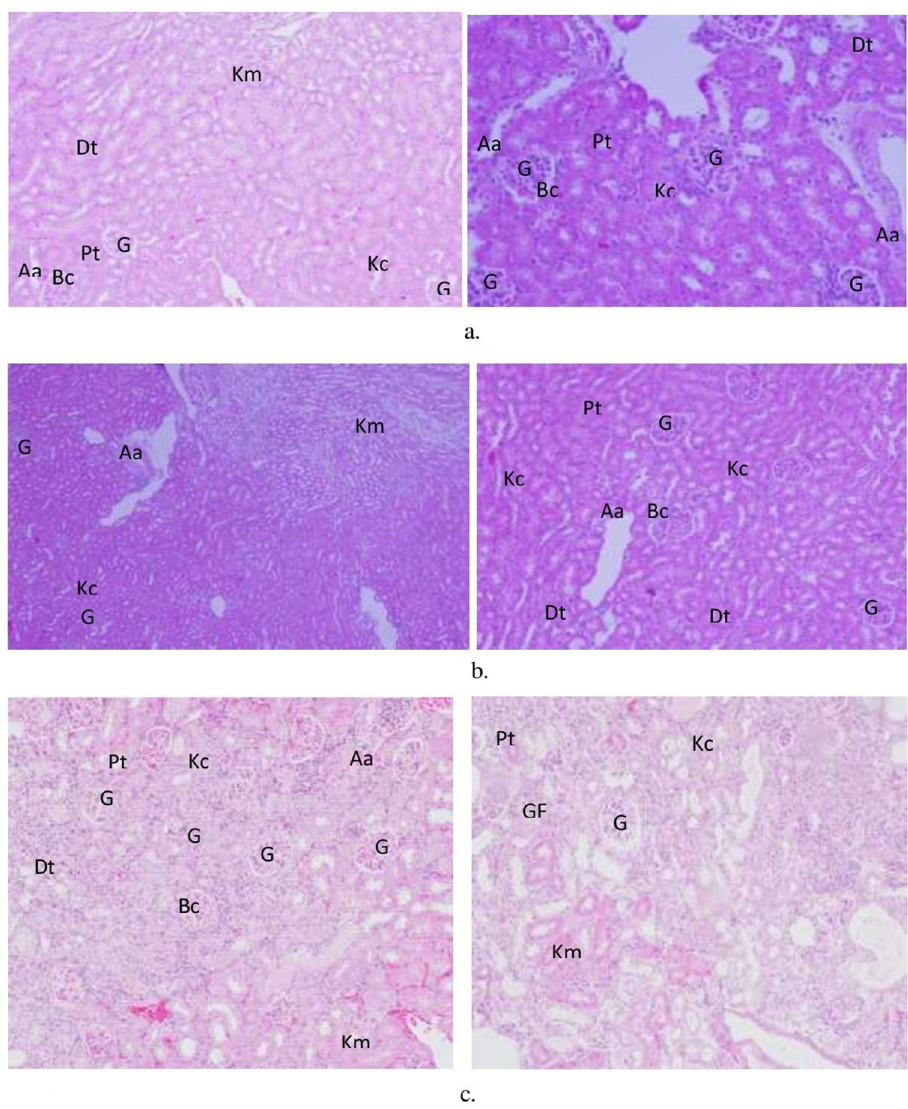
Figure 4: ( a – c ) Sections picture of the kidney of male and female mice treated with RVWSE: before mating ( group 1 ) and during pregnancy ( group II ) ( 100 × or 200 × magni fi cation ) . [ Pt = proximal collecting tubules, Dt = distal collecting tubules, G = glomerulus, Bc = Bowman capsule, Kc = kidney cortex, Km = kidney medulla, Aa = a ff erent arterioles ] . ( a ) Group I female kidney control (× 100 ) and Group I female kidney treated (× 200 ) . ( b ) Group II female kidney control (× 100 ) and Group II female kidney treated (× 100 ) . ( c ) Male kidney control (× 100 ) and male kidney treated (× 100 )